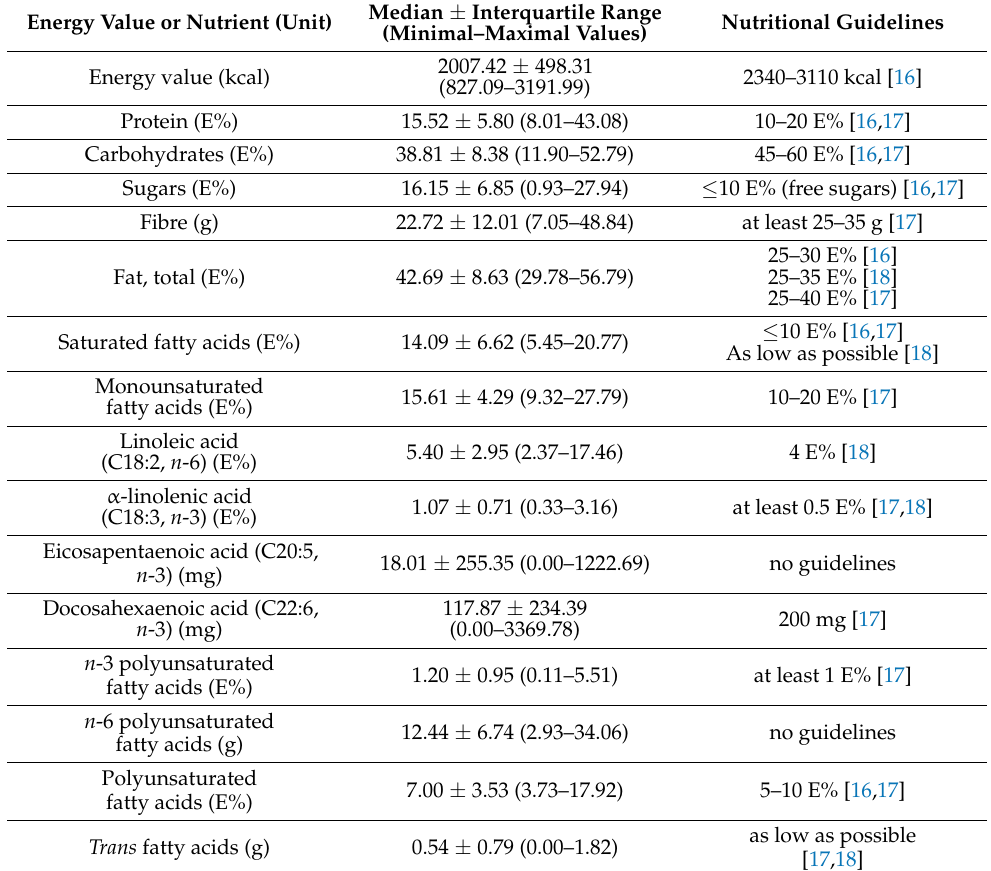
Table 3. Daily energy and nutrient intakes in comparison to nutritional guidelines (median values from 72-h food